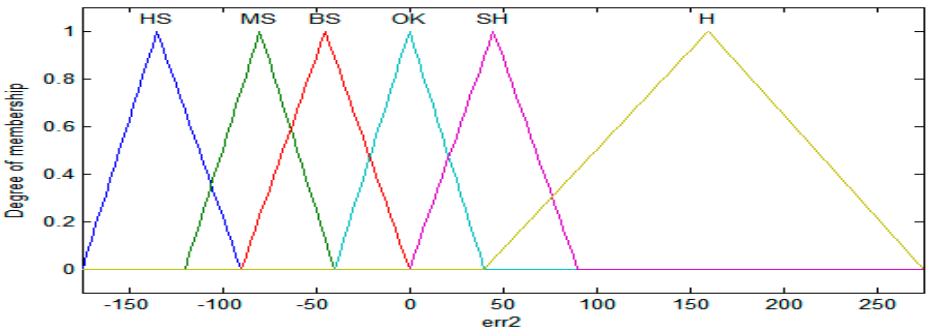
Figure 8. Illumination fuzzy controller inputs.